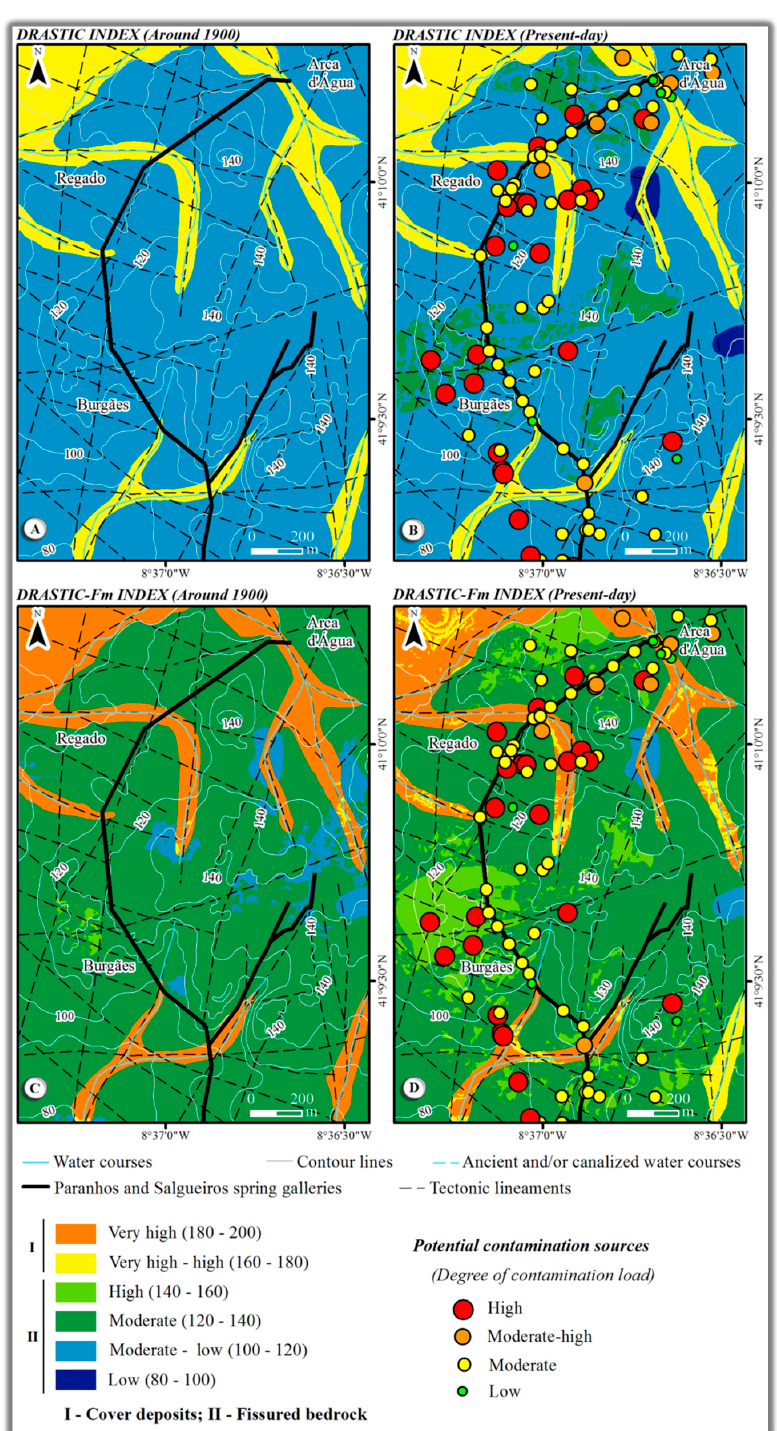
Figure 7. DRASTIC ( A , B ) and DRASTIC ‐ Fm ( C , D ) vulnerability maps, and potential contamination sources for the present ‐ day